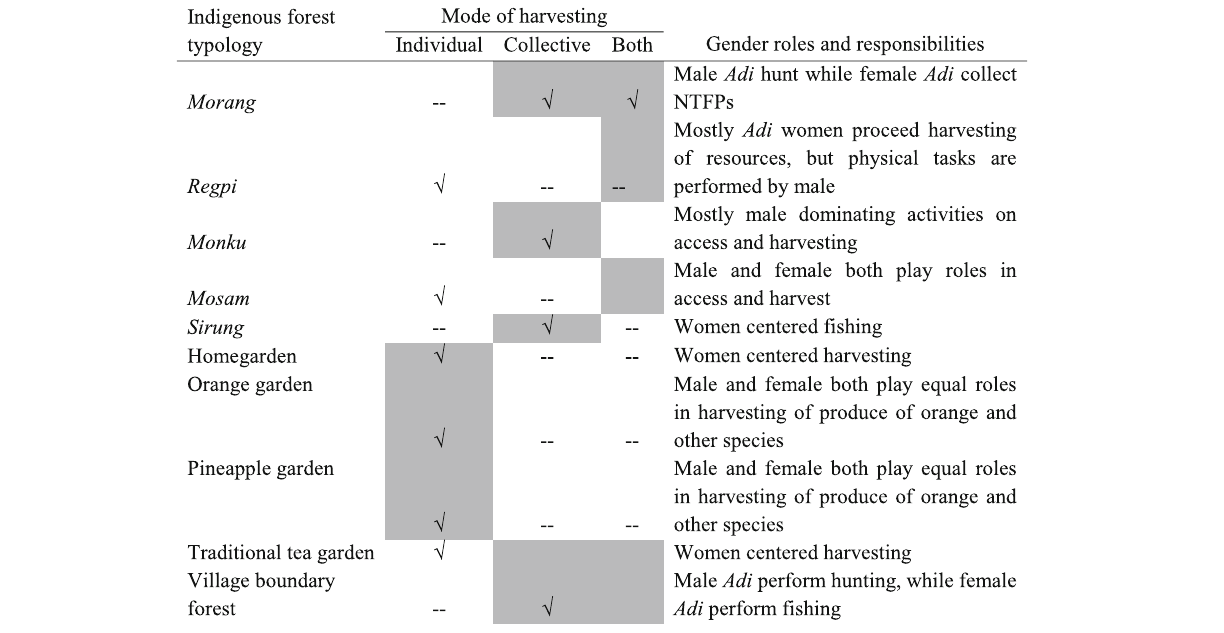
Table 6 Access and harvesting strategies used by Adi tribe